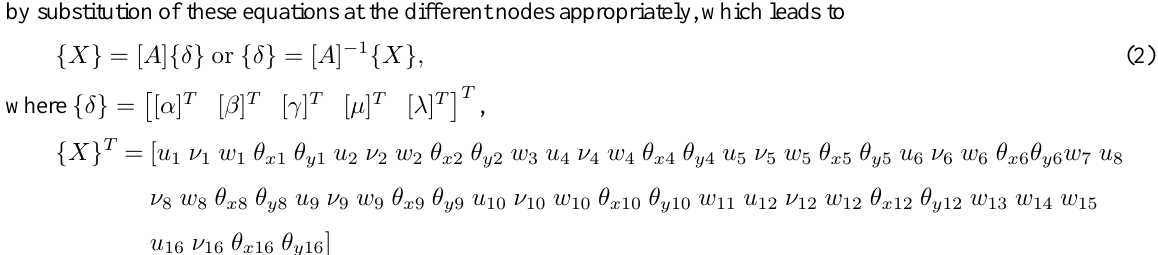
a analysis based on proposed element using MLS-2 as the mass lumping scheme. b indicates mesh